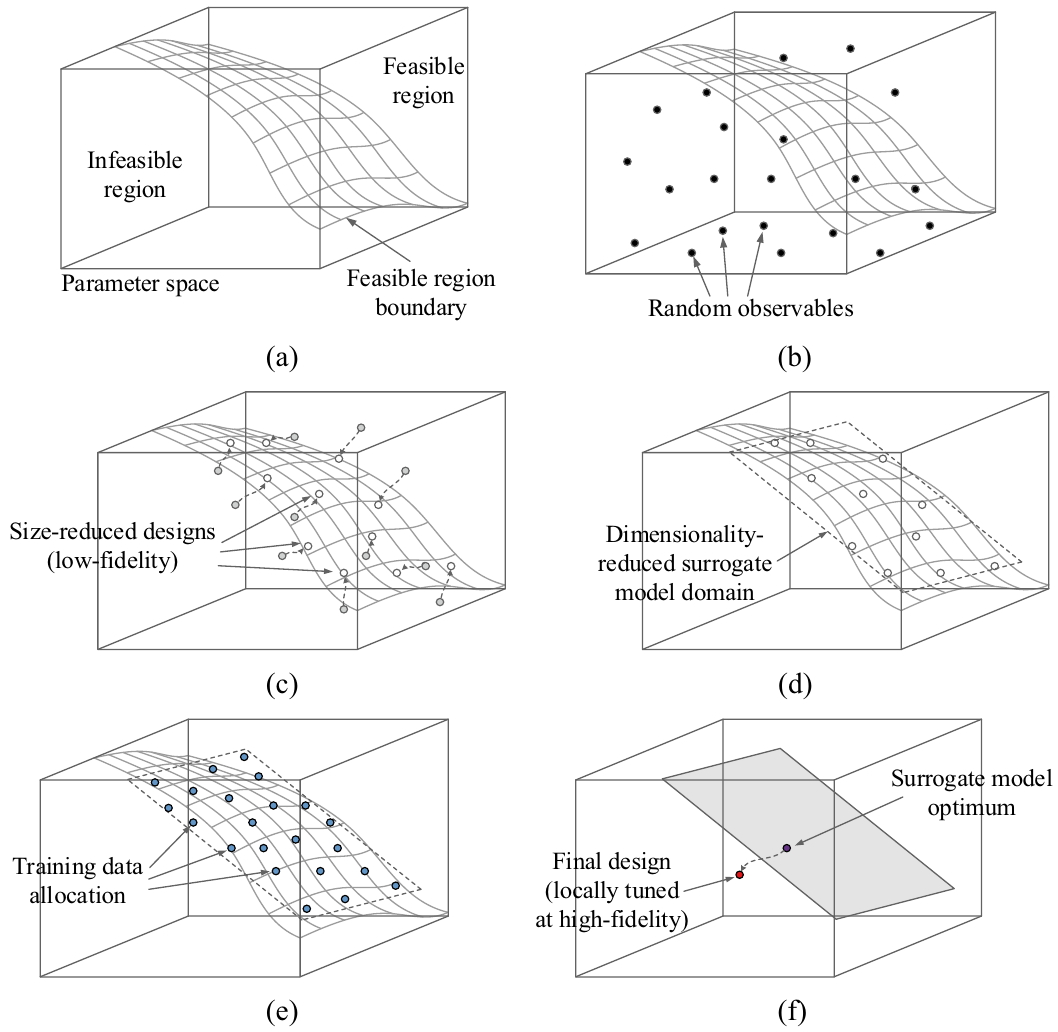
Figure 1. Conceptual illustration of the proposed globalized size reduction procedure involving variable- resolution EM models and dimensionality reduction: ( a ) Exemplary parameter space with feasible and infeasible region indicated along with the boundary region marked in grey, ( b ) Stage 1: allocation of random observables; the acquired EM data will be used to approximate the feasible region boundary, ( c ) Stages 2 and 3: selected observables are optimized for size reduction at low-fidelity EM level, ( d ) Stage 4: spectral analysis of the pre- optimized observables is used to define the domain of the surrogate model in the boundary area, ( e ) Stage 5: training data is allocated in the domain, and kriging interpolation model is constructed, ( f ) Stages 6 and 7: the design obtained through global optimization of surrogate model is finally tuned at high-fidelity level using gradient-based